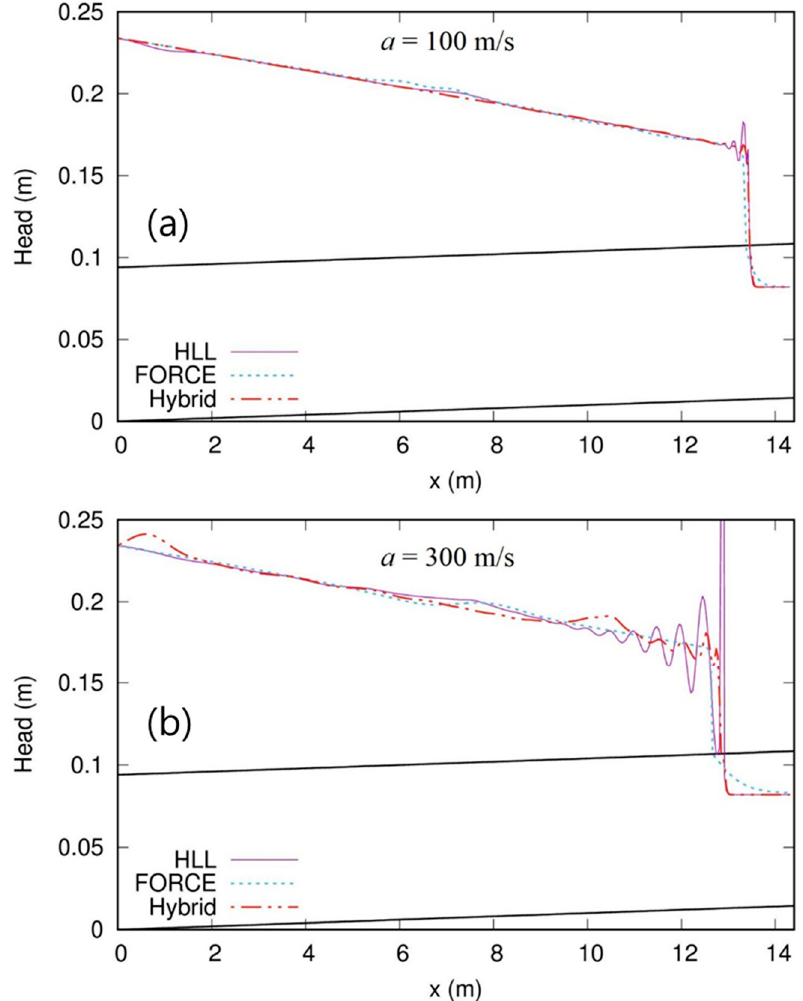
Figure 4. Hydraulic-head profiles simulated by different flux schemes at 6 s (Test 2) with ( a ) a = 100 m/s; ( b ) a = 300 m/s.